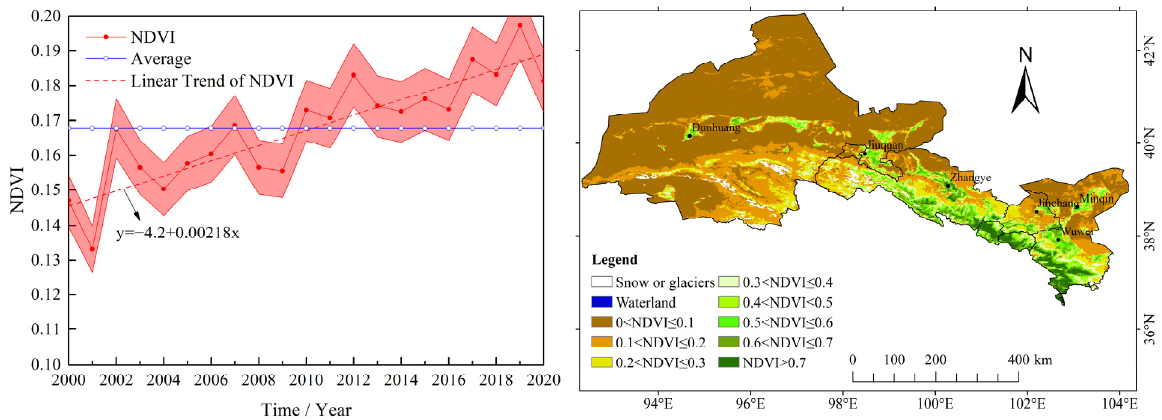
Figure 4. Spatiotemporal distribution of growing season NDVI during